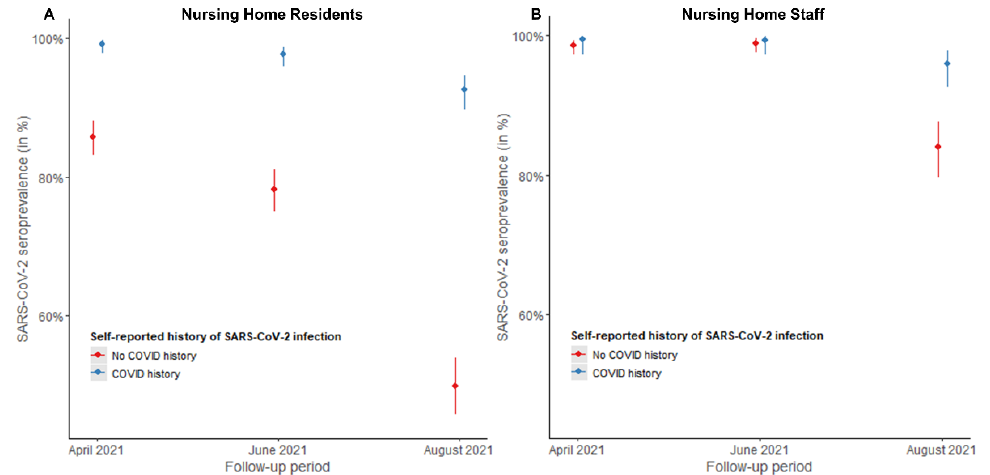
Figure 2. Adjusted seroprevalence among nursing home residents ( A ) and staff ( B ) with and without self-reported history of SARS-CoV-2 infection, Belgium, two (April 2021), four (June 2021) and six months (August 2021) after COVID-19 vaccination. SARS-CoV-2 seroprevalence was estimated based on a generalized estimating equation model averaged over nursing homes. Blue dots represent the seroprevalence among participants with a self-reported history of SARS-CoV-2 infection; red dots represent the seroprevalence among participants without self-reported history of SARS-CoV-2 infection. The error bars represent the 95% confidence intervals of these means. A history of COVID- 19 infection was defined as a previously self-reported positive PCR and/or rapid antigen test, and/or CT-scan between February 2020 and the moment of antibody